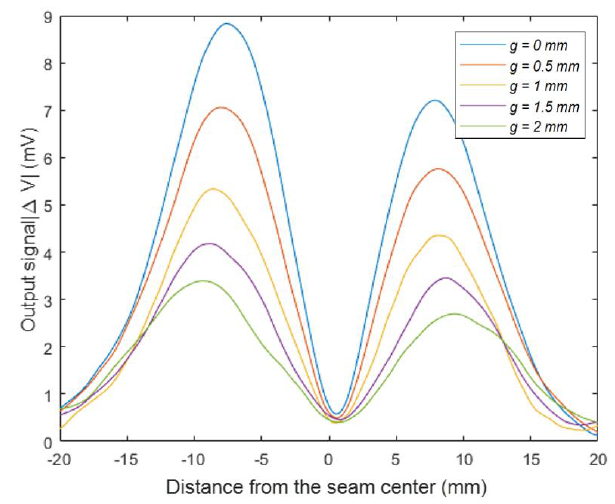
Figure 12. The sensor output signal with a variable gap distance .